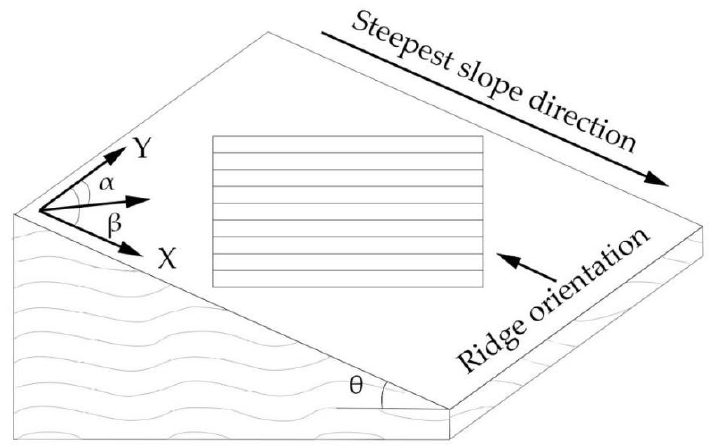
Figure 2. Diagram of ridge orientation: α , ridge angle; β , azimuth angle; θ , slope gradient.